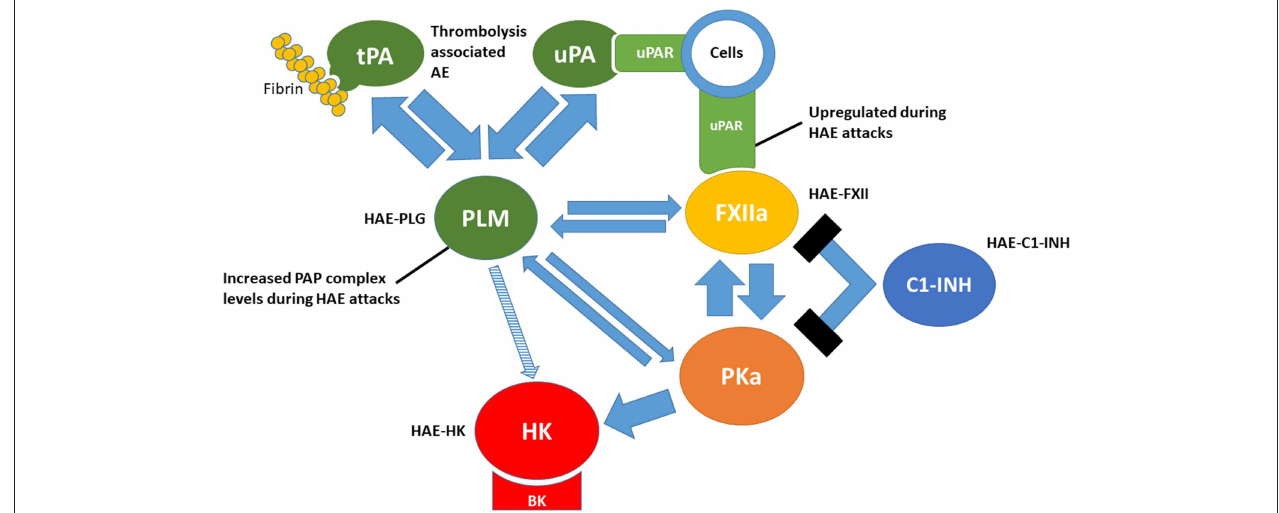
FIGURE 1 | Links between the plasminogen activation and contact activation. tPA, tissue-type plasminogen activator; uPA, urokinase-type plasminogen activator; uPAR, urokinase-type plasminogen activator receptor; PLM, plasmin; FXIIa, activated factor XII; PKa, plasma kallikrein; HK, high molecular-weight kininogen; BK, bradykinin; C1-INH, C1 inhibitor. PAP, plasmin- α 2-antiplasmin. HAE-PLG, HAE-FXII, HAE-C1-INH and HAE-HK represent forms of hereditary angioedema related to gain-offunction mutations in each